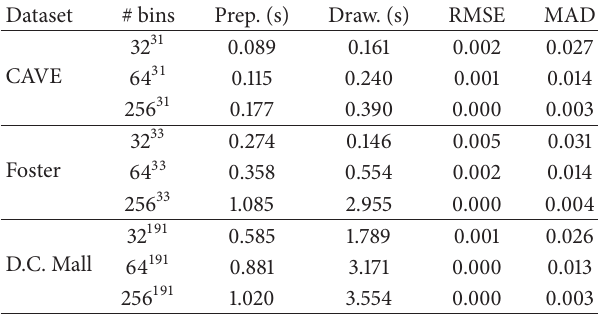
Table 1: Datasets used for evaluation.